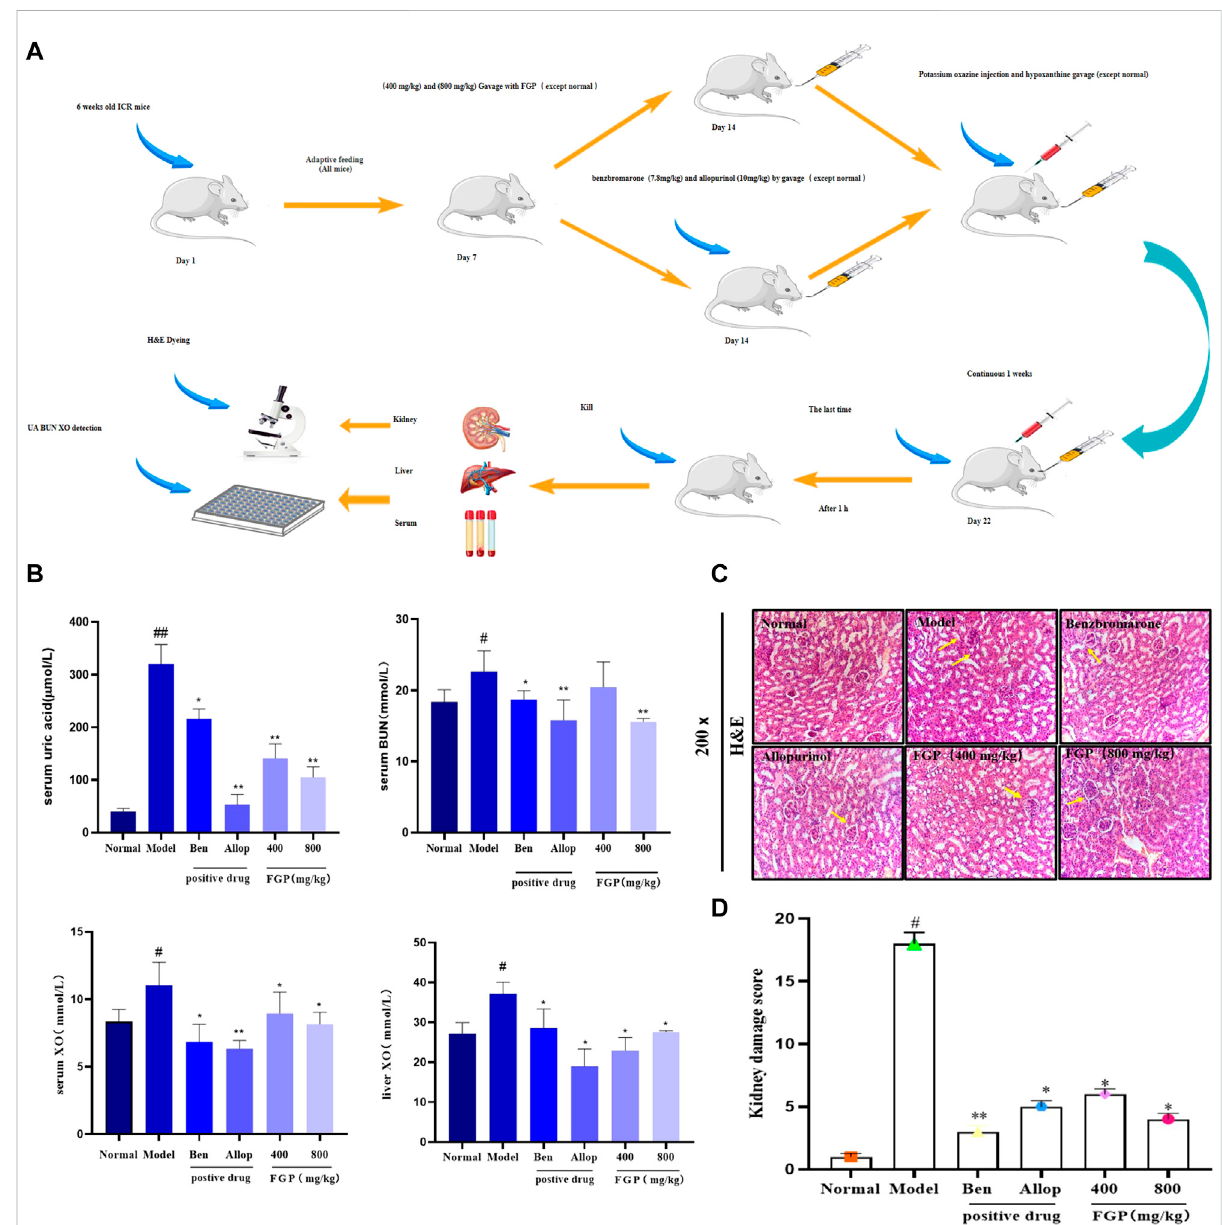
FIGURE 4 Effectsonrelated indexesinHUAmice.Experimentalanimalsanddesignprocess (A) .EffectsofFGPonUA,BUNlevelsintheseruminmiceand effects of FGP on XO activities in the liver and serum in mice (B) ; Histological examination of the kidney (200 ×) (C) ; Pathological changes of kidney andRiditanalysis (D) .Dataareexpressedasthemean±SD( n =8). # p < 0.05, ## p < 0.01vs.normalgroup;* p < 0.05,** p < 0.01or*** p < 0.001vs.HUA